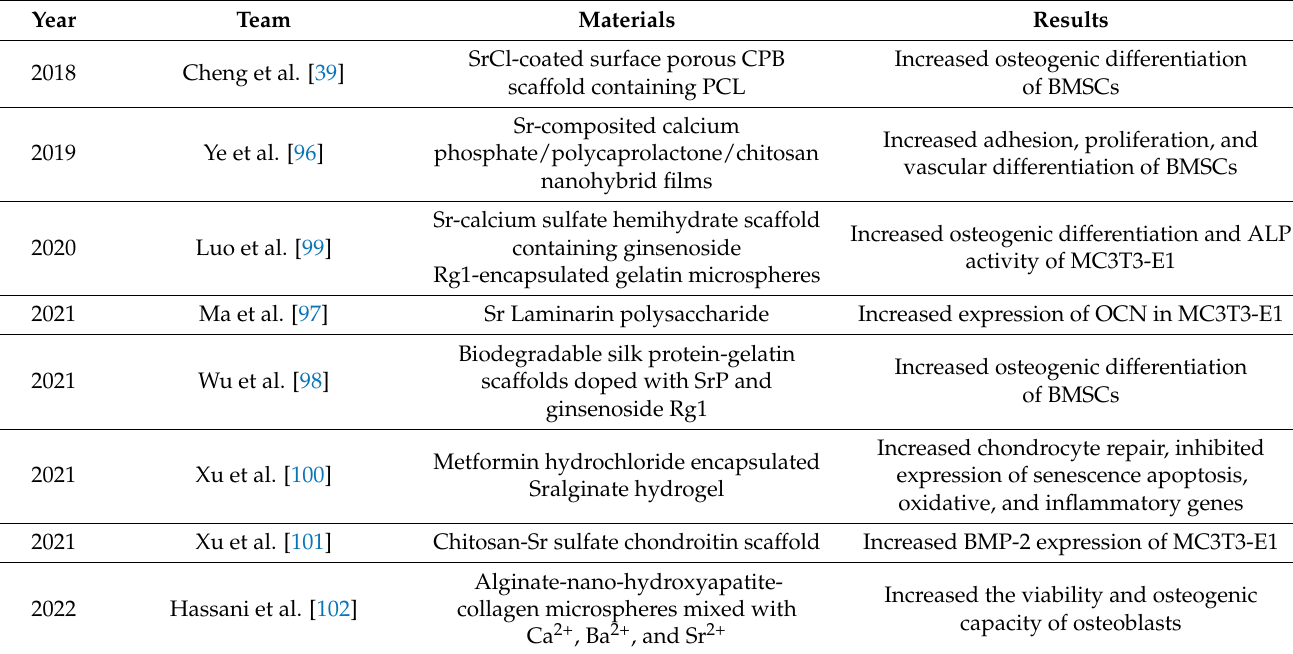
Table 4. The application of Sr compound with natural